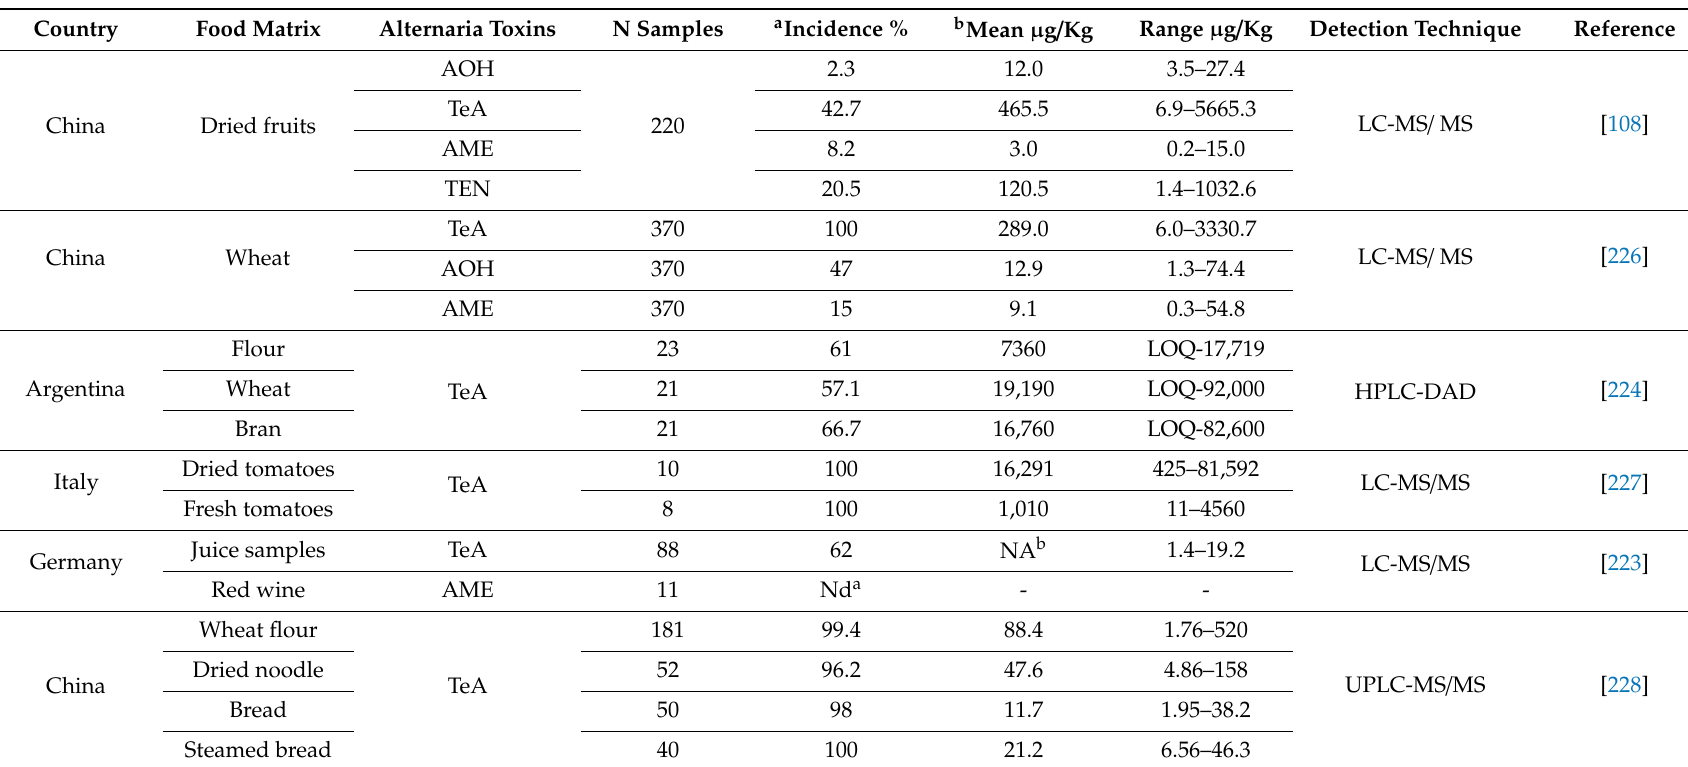
Table 11. Representative studies on the occurrence of Alternaria toxins distribution ( µ g / kg or µ g / L) in food samples around the world during 2014–2019.